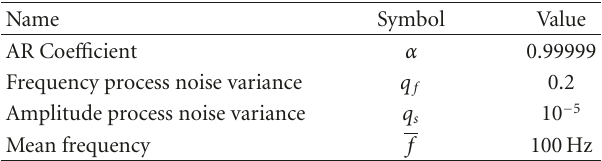
Table 2: Synthetic signal generation